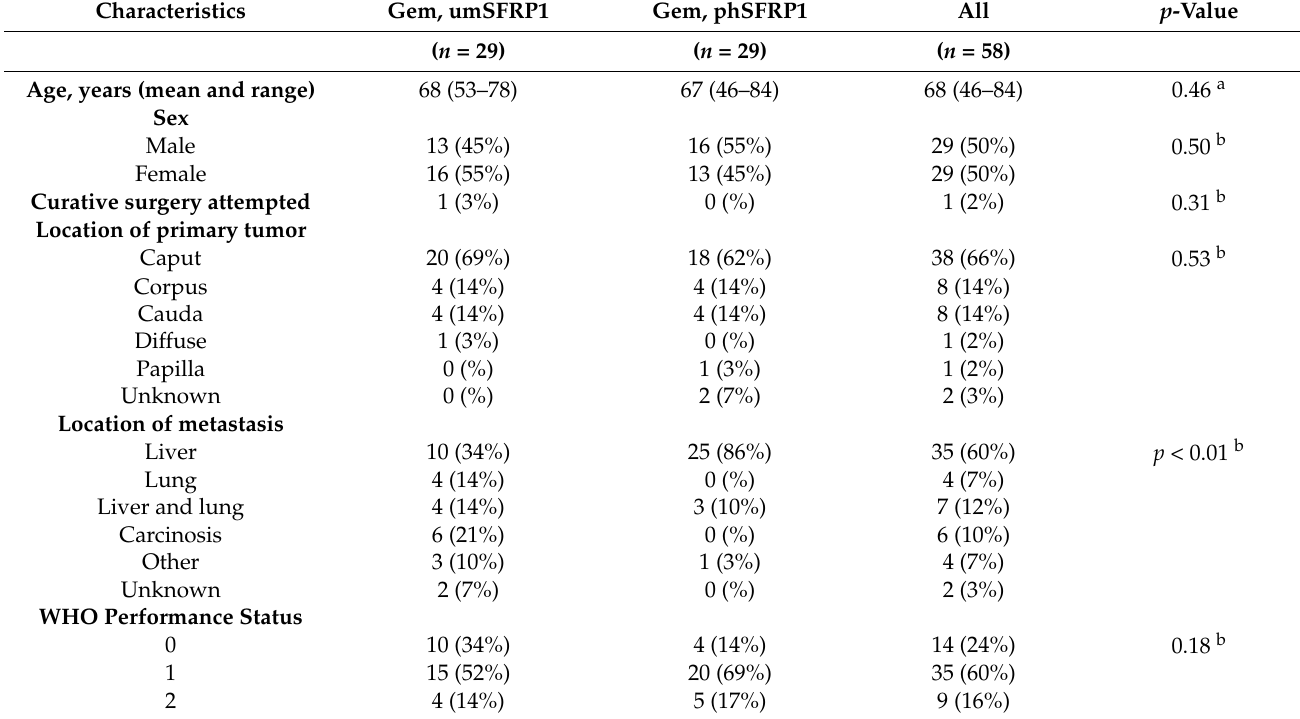
Table 3. Characteristics on PDAC patients from the validation